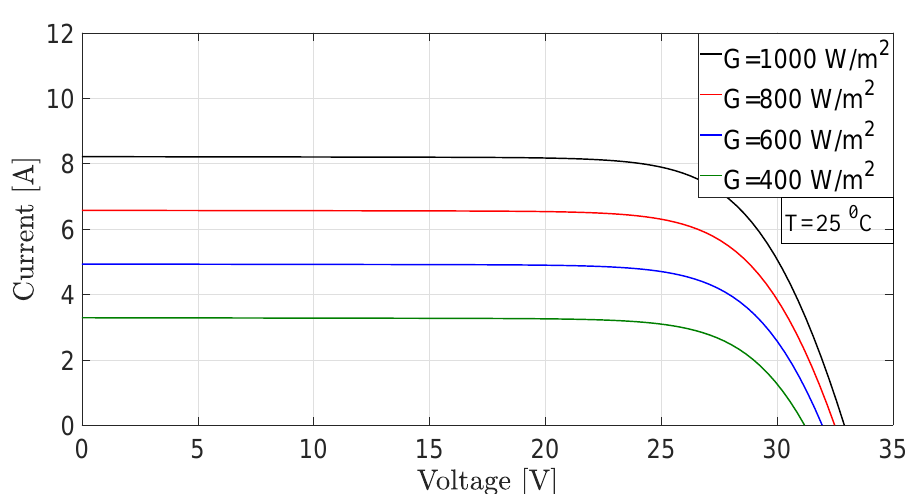
Figure 2. I–V characteristics of the PV source under different radiation conditions.